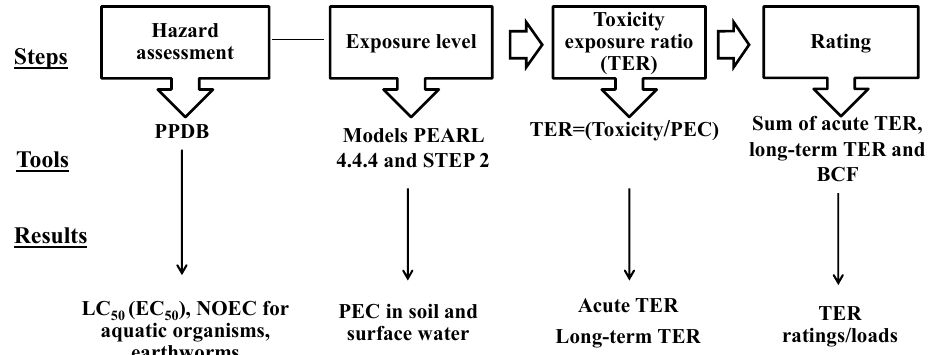
Figure 1. A step-by-step scheme of the hazard assessment and toxicity exposure ratios (TER) of pesticides for aquatic organisms and earthworms. LC/EC: lethal concentration; NOEC: no observed effect concentration; BCF: bioconcentration factor; PEC: predicted environmental concentration.